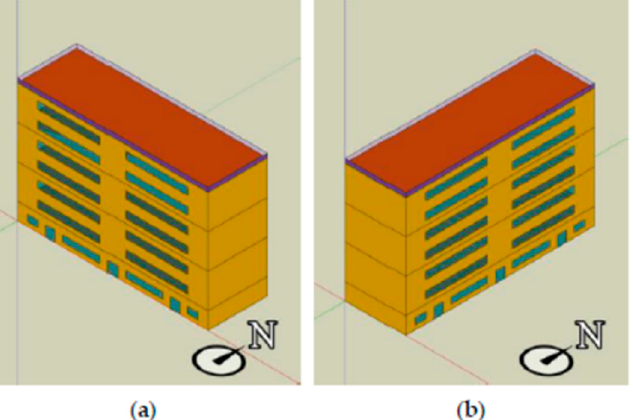
Figure 8. Building with north-south and east-west orientations (axonometric view of the building model in: ( a ) north-south and ( b ) east-west orientations).